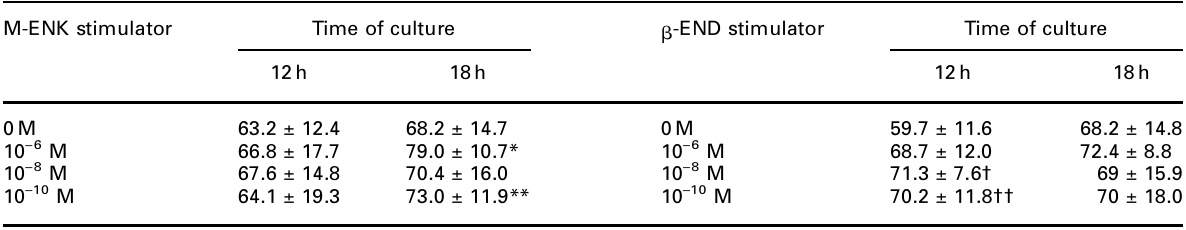
Table 2. The effect of opioid peptides on spontaneous neutrophil apoptosis in vitro measured by ANX-FITC and PI binding M-ENK stimulator